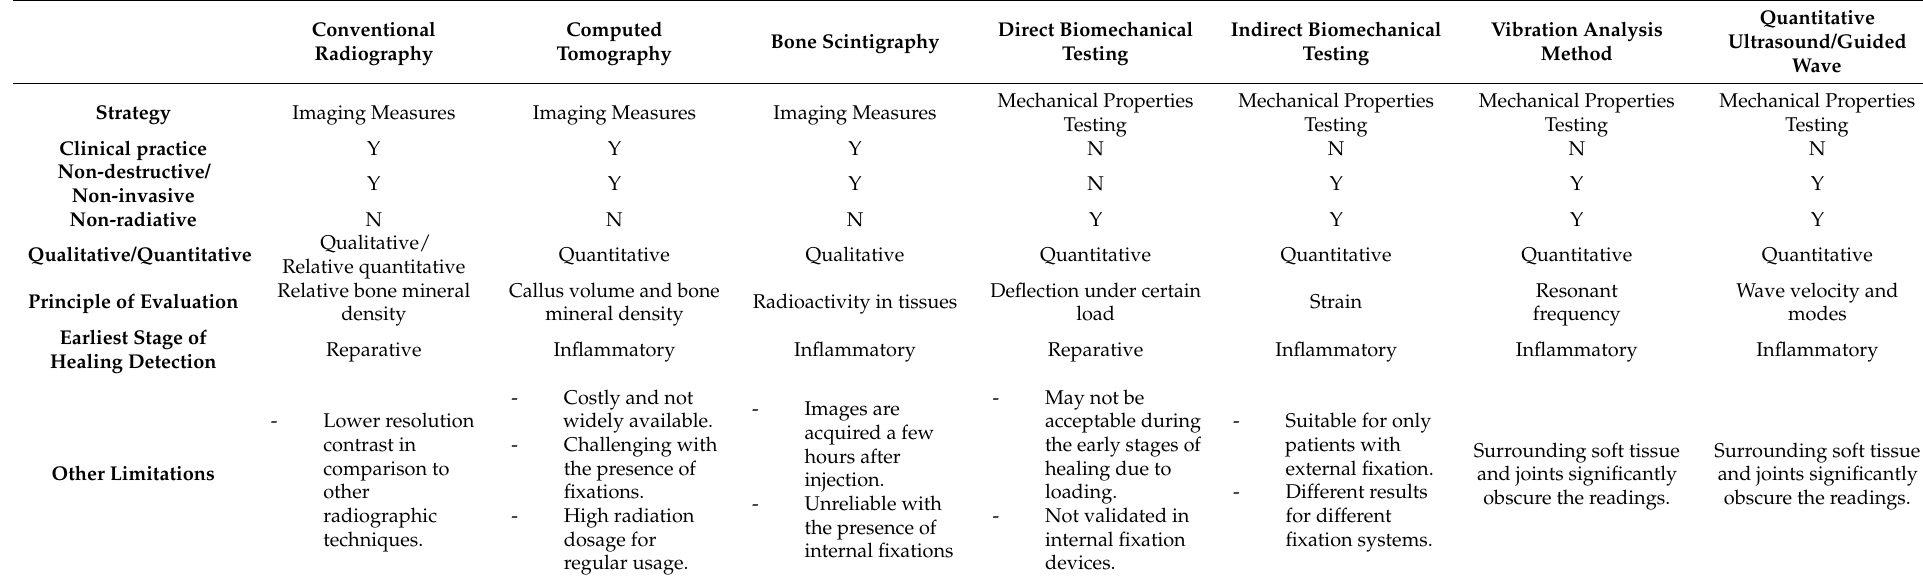
Table 1. Comparison of different assessment methods of fracture